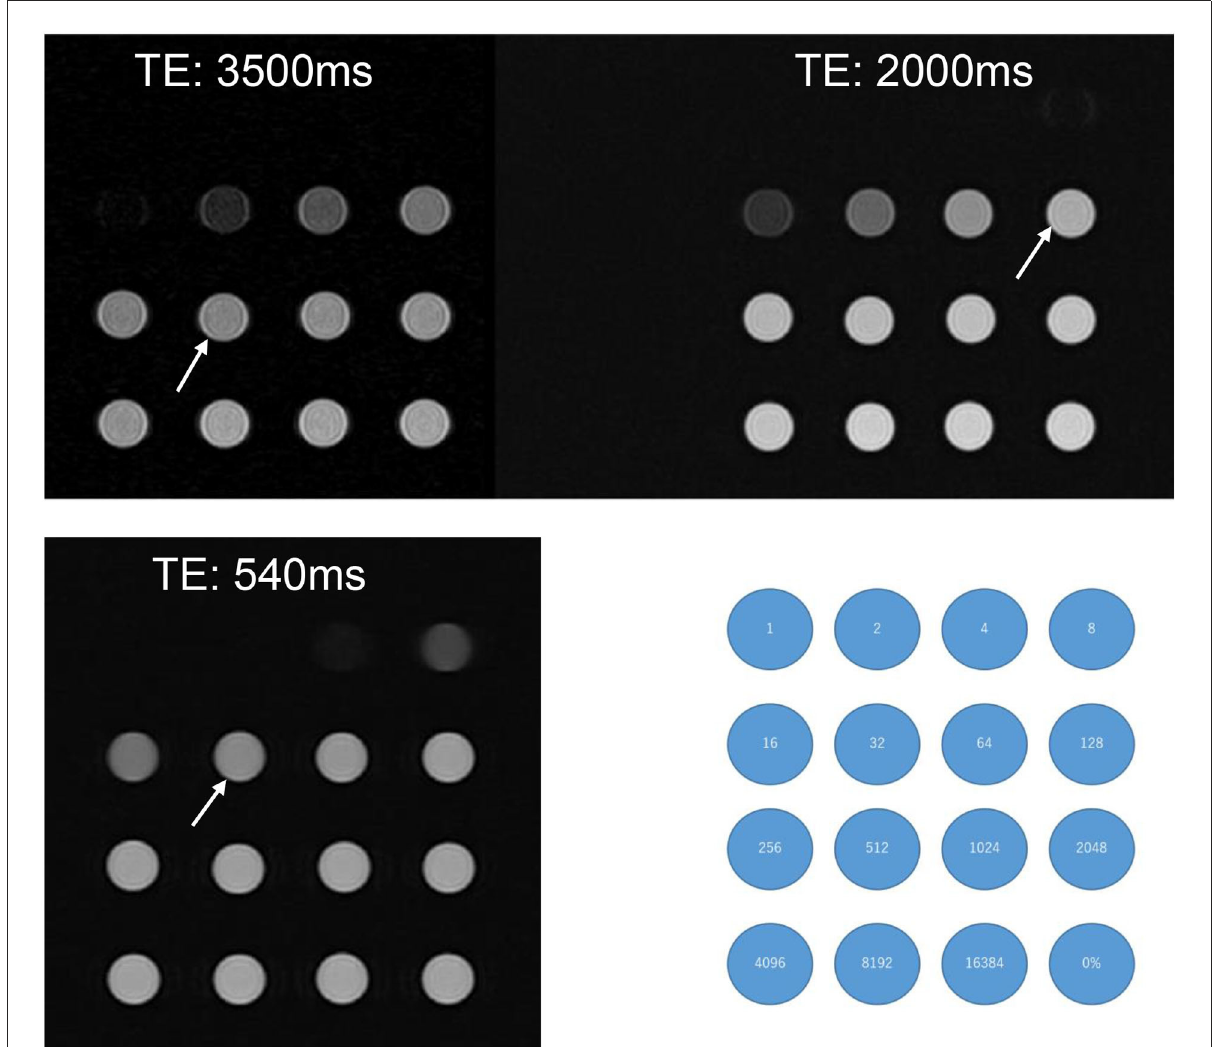
FIGURE1 A phantom experiment with test tubes of various 17 O-saline concentrations. 10 mol% 17 O-saline was diluted with normal saline. Numbers in the blue circles indicate the dilutions. The right lower corner tube (0%) indicates the tube filled with normal saline. Compared with normal saline, the slight signal decrease for 17 O-saline was barely recognizable for the 512 times dilution for a TE of 3,500ms (arrow), 128 times dilution for a TE of 2,000ms (arrow), and 32 times dilution for a TE of 540ms (arrow). Even at a TE of 540ms, dilutions of < 8 did not produce a visible